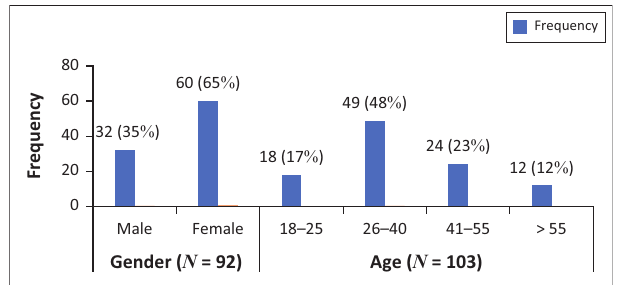
FIGURE 1: Age and gender distributions.